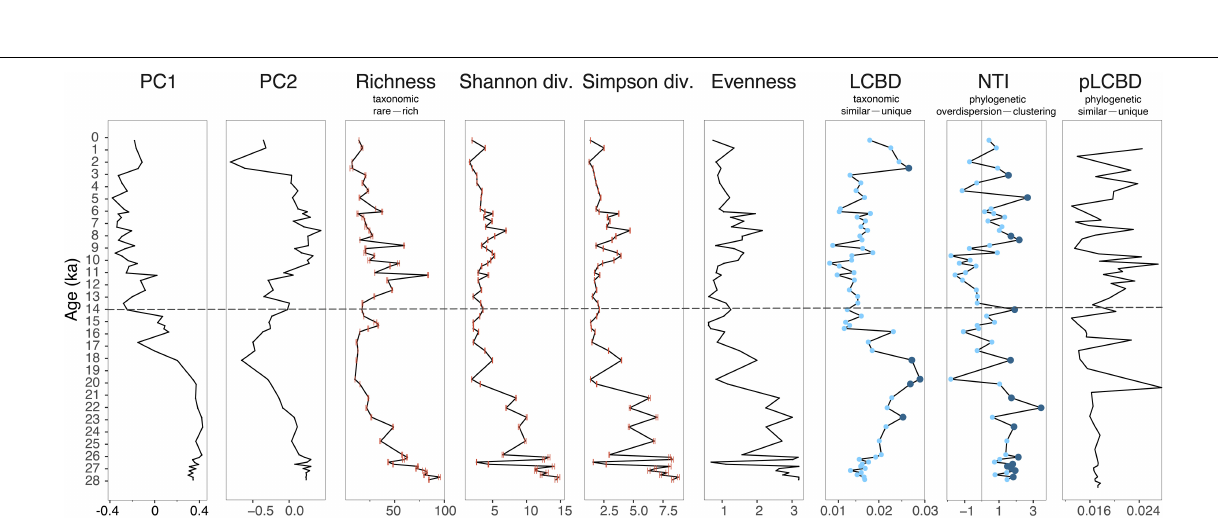
Frontiers in Ecology and Evolution |